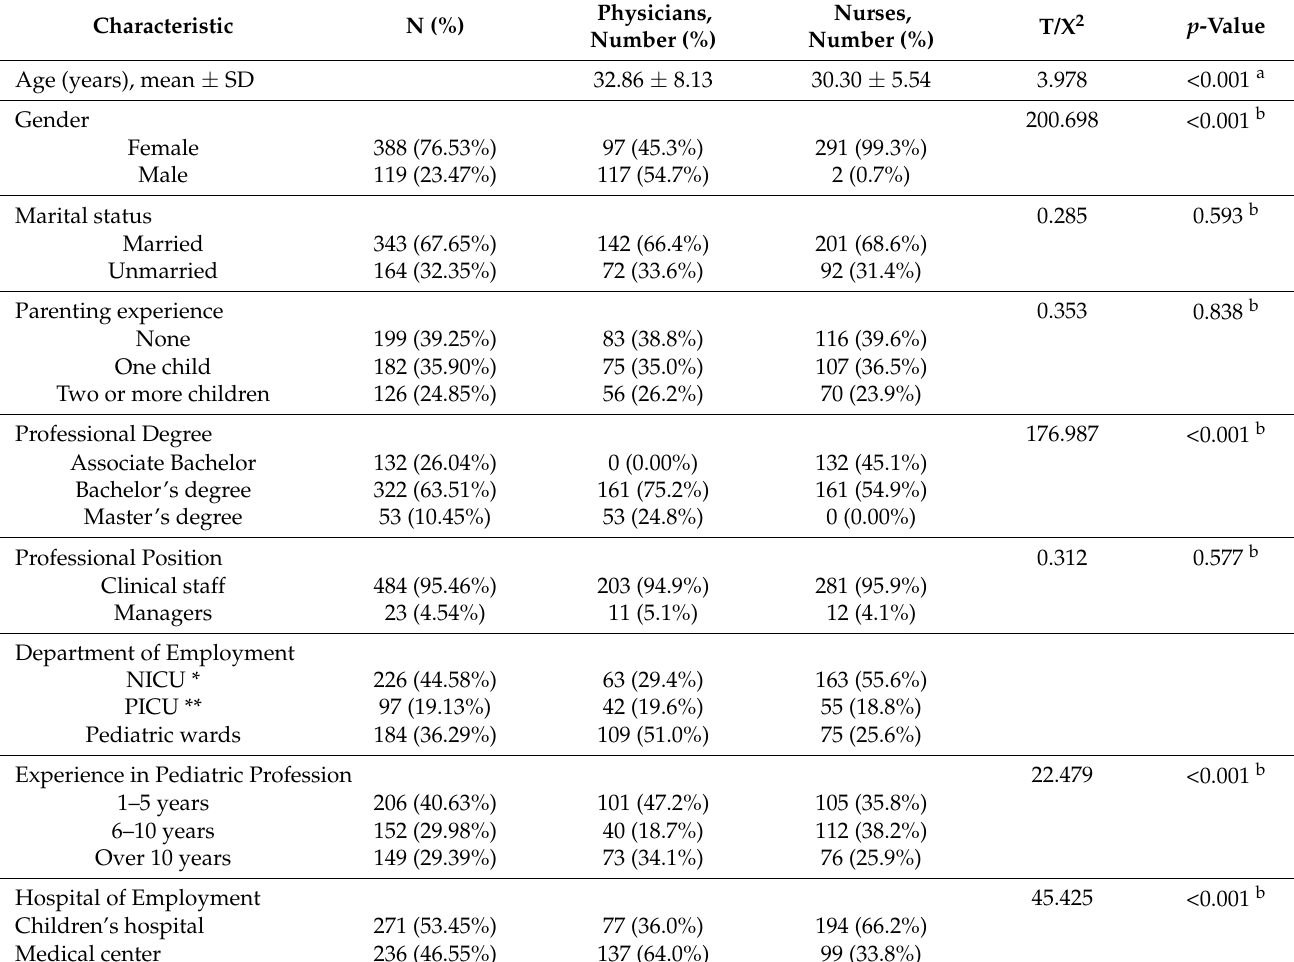
Table 1. Demographic profile of participants (N = 507; 214 physicians and 293